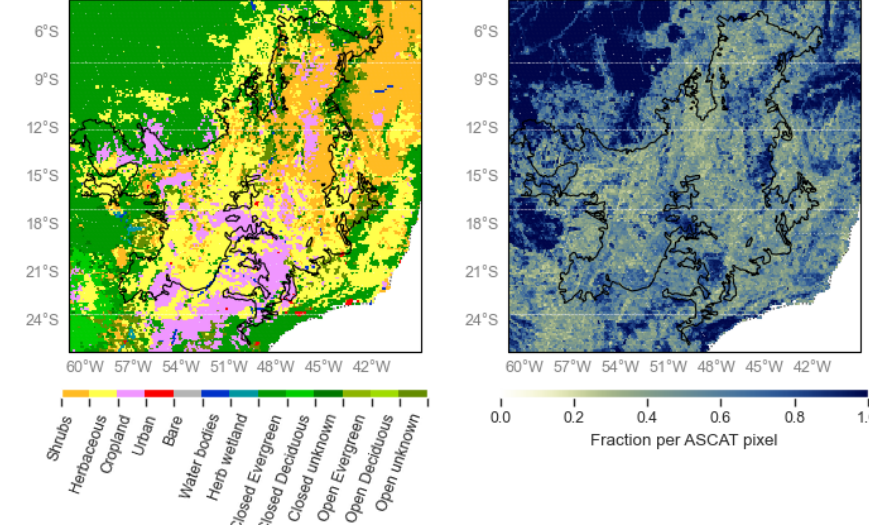
Figure 7. Dominant land cover type (left panel) and fraction (right panel) derived from the Copernicus Global Land Service Land Cover (2015) for the Cerrado region (Buchhorn et al.,